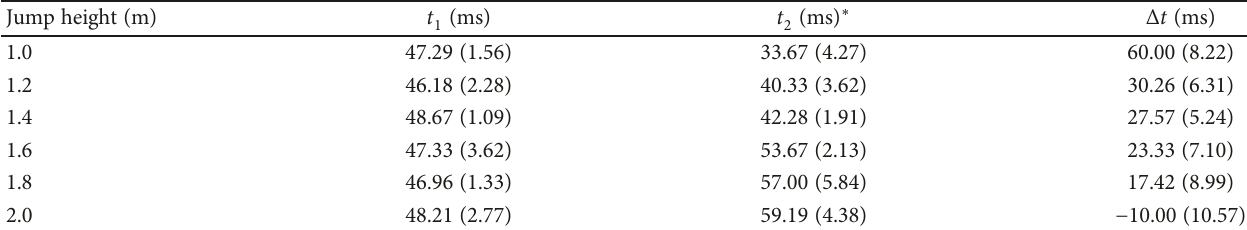
Table 2: Means and SD of the bu ff ering durations of the RF ( t paws and the hind paws, for di ff erent jump heights a . Jump height (m)